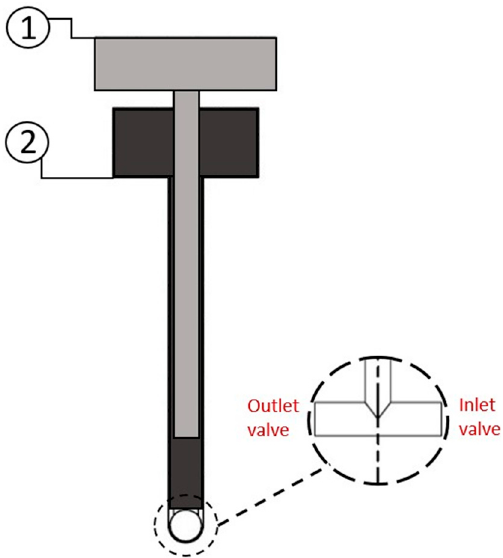
Figure 2. The cross-section A-A of the two essential parts of a Searaser. According to Figure 2, which is adapted from [12], the converter has an inlet and outlet gages for the water flow to enter and exit during the buoy’s movement.